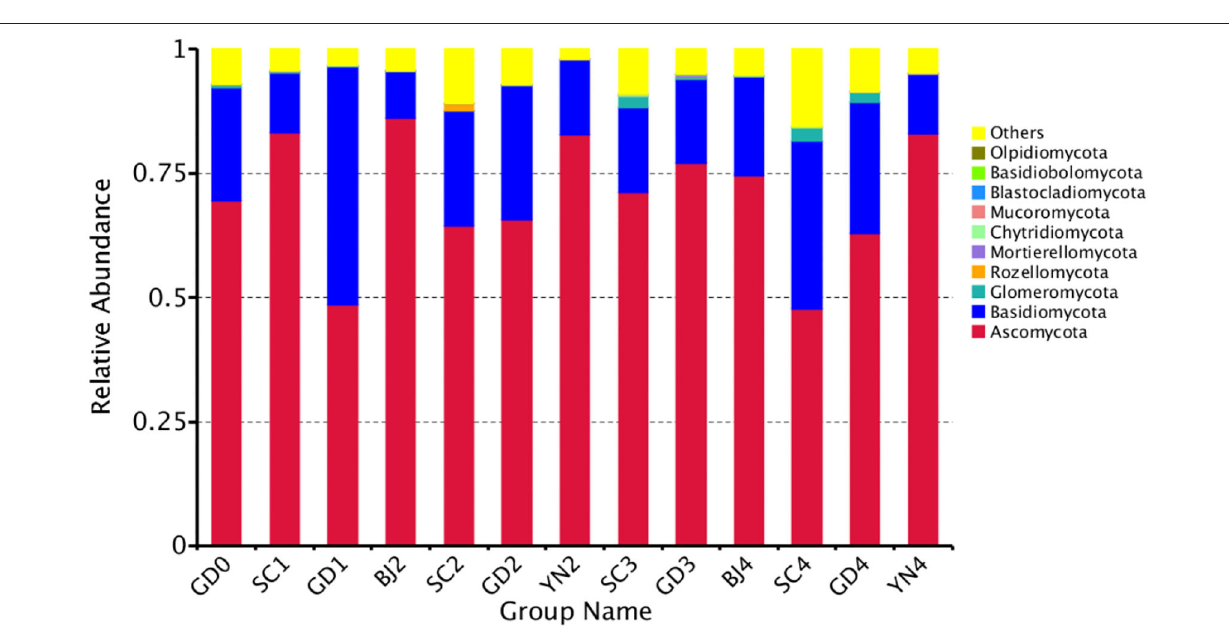
FIGURE 4 | Relative abundance of fungi at phylum levels. Distribution of 10 most abundant fungal phylum present in Citrus reticulata “Chachi” samples. “Others” in the last column refers to the sum of less abundant fungal phylum. Each number represents average of three